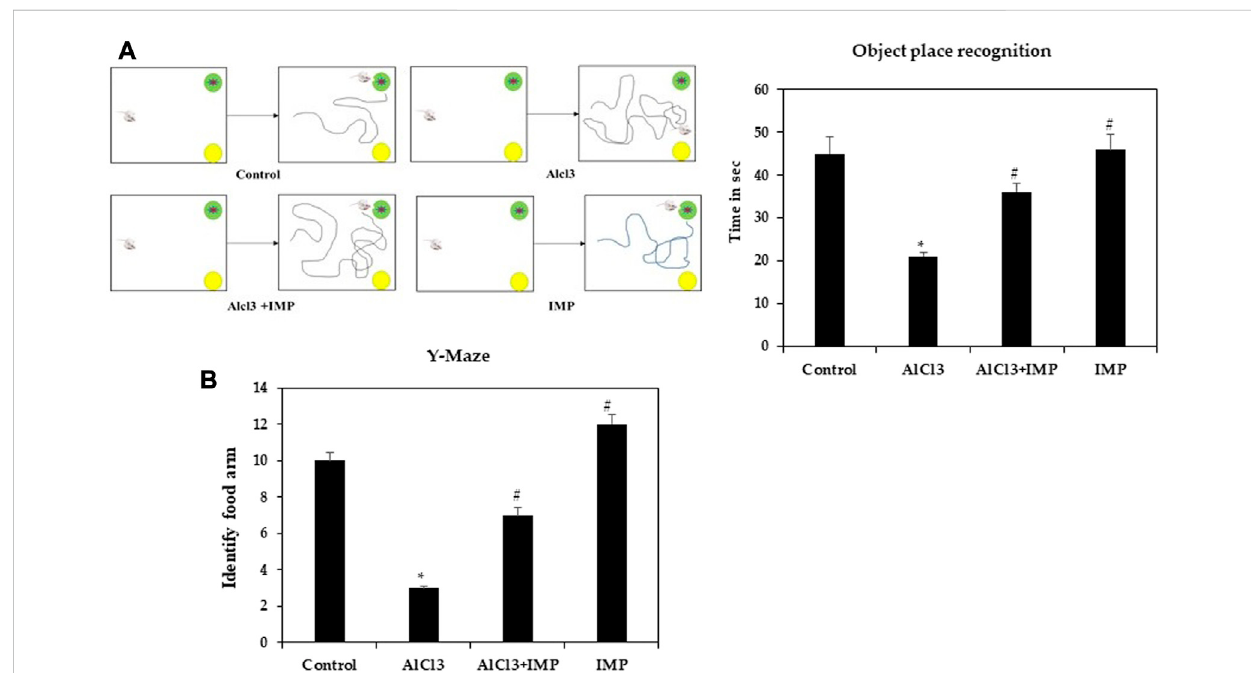
FIGURE 2 Spatial memory learning of mice. (A) Object place recognition test. (B) Y-maze test. The difference between the treatment and control groups was statisticallysigni fi cant;* p < 0.05,# p < 0.05wasconsideredstatisticallysigni fi cant.Valuesareexpressedasmean±SD, n =3.* p < 0.05indicatesthatthere are signi fi cant differences between the AlCl3 alone group and the control group. # p < 0.05 shows signi fi cant differences between AlCl3 alone and IMP with